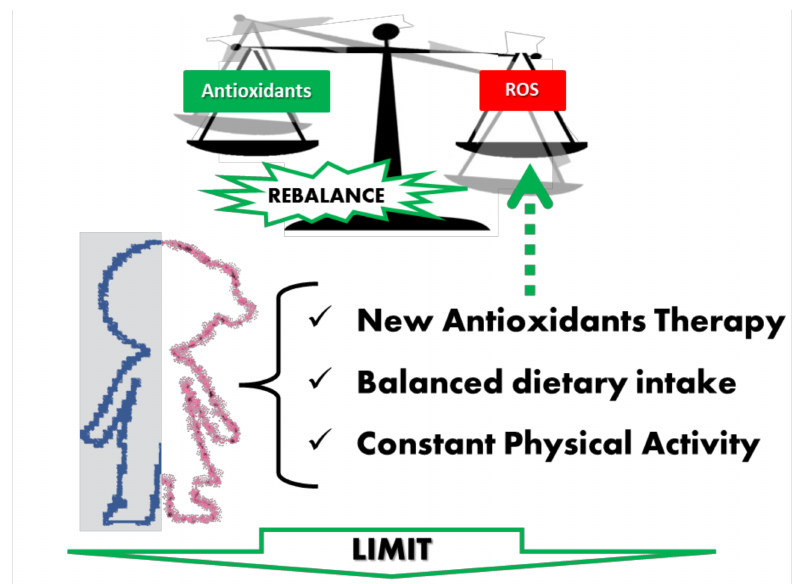
Figure 2. Proposed pharmacological and lifestyle interventions that might prevent oxi- dant/antioxidant imbalance in